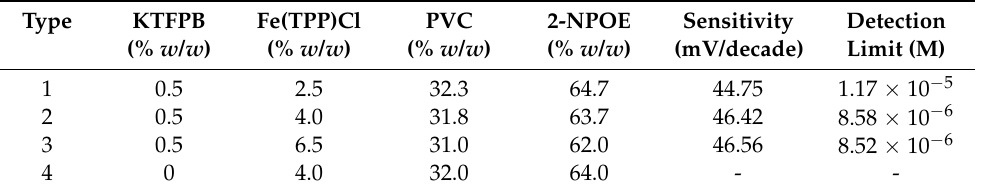
Table 1. Membrane composition and performance of histamine electrodes.